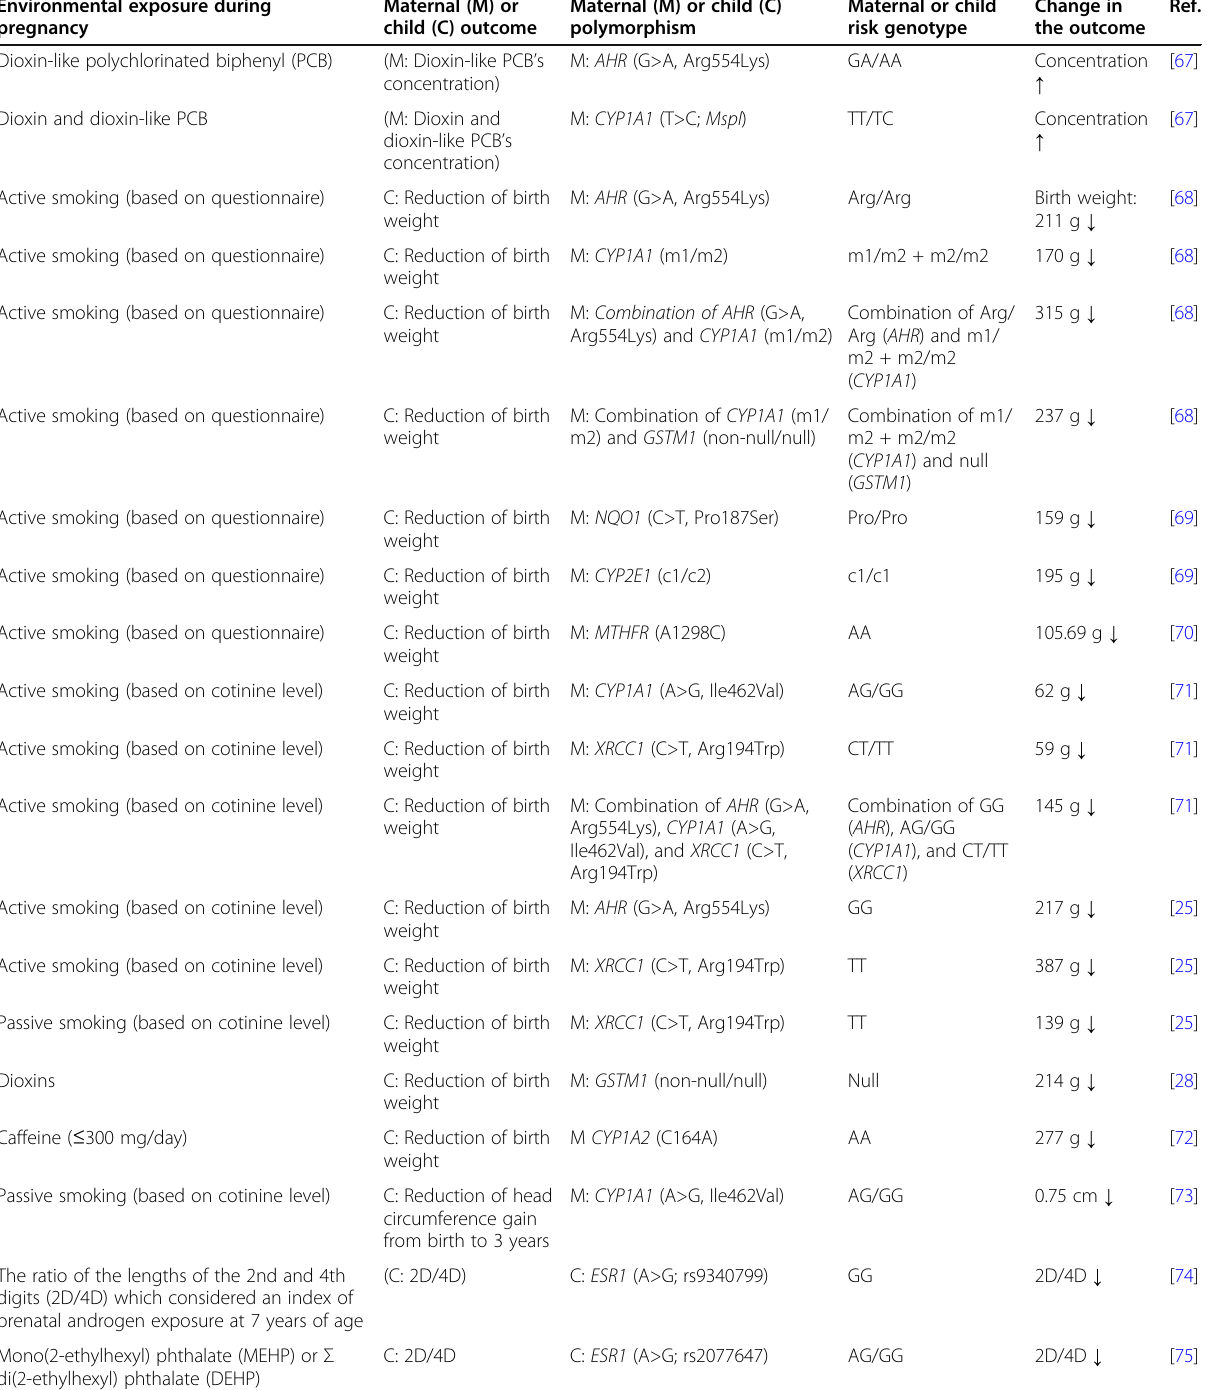
Table 6 Environmental exposure during pregnancy and maternal and child outcomes: gene – environment interactions (only significant) in the literature after 2017 in the Hokkaido Study on Environment and Children ’ s Health Environmental exposure during pregnancy